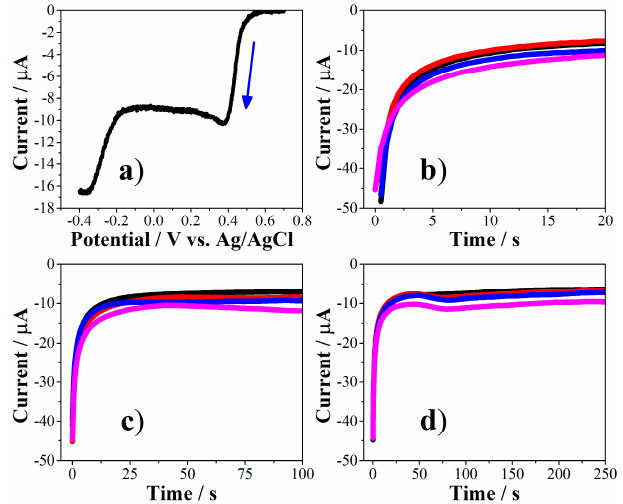
Figure 4. Electrodeposition of gold nanoparticles (AuNPs) on screen-printed electrodes. Linear sweep voltammogram (5.0 mV/s) of gold precursor ( a ). Current vs. time curves at 20 s ( b ), 100 s ( c ) and 250 s ( d ). The applied potentials were +0.05 V (black lines), − 0.05 V (red lines), − 0.15 V (blue lines) and − 0.25 V (rose lines) in all cases.